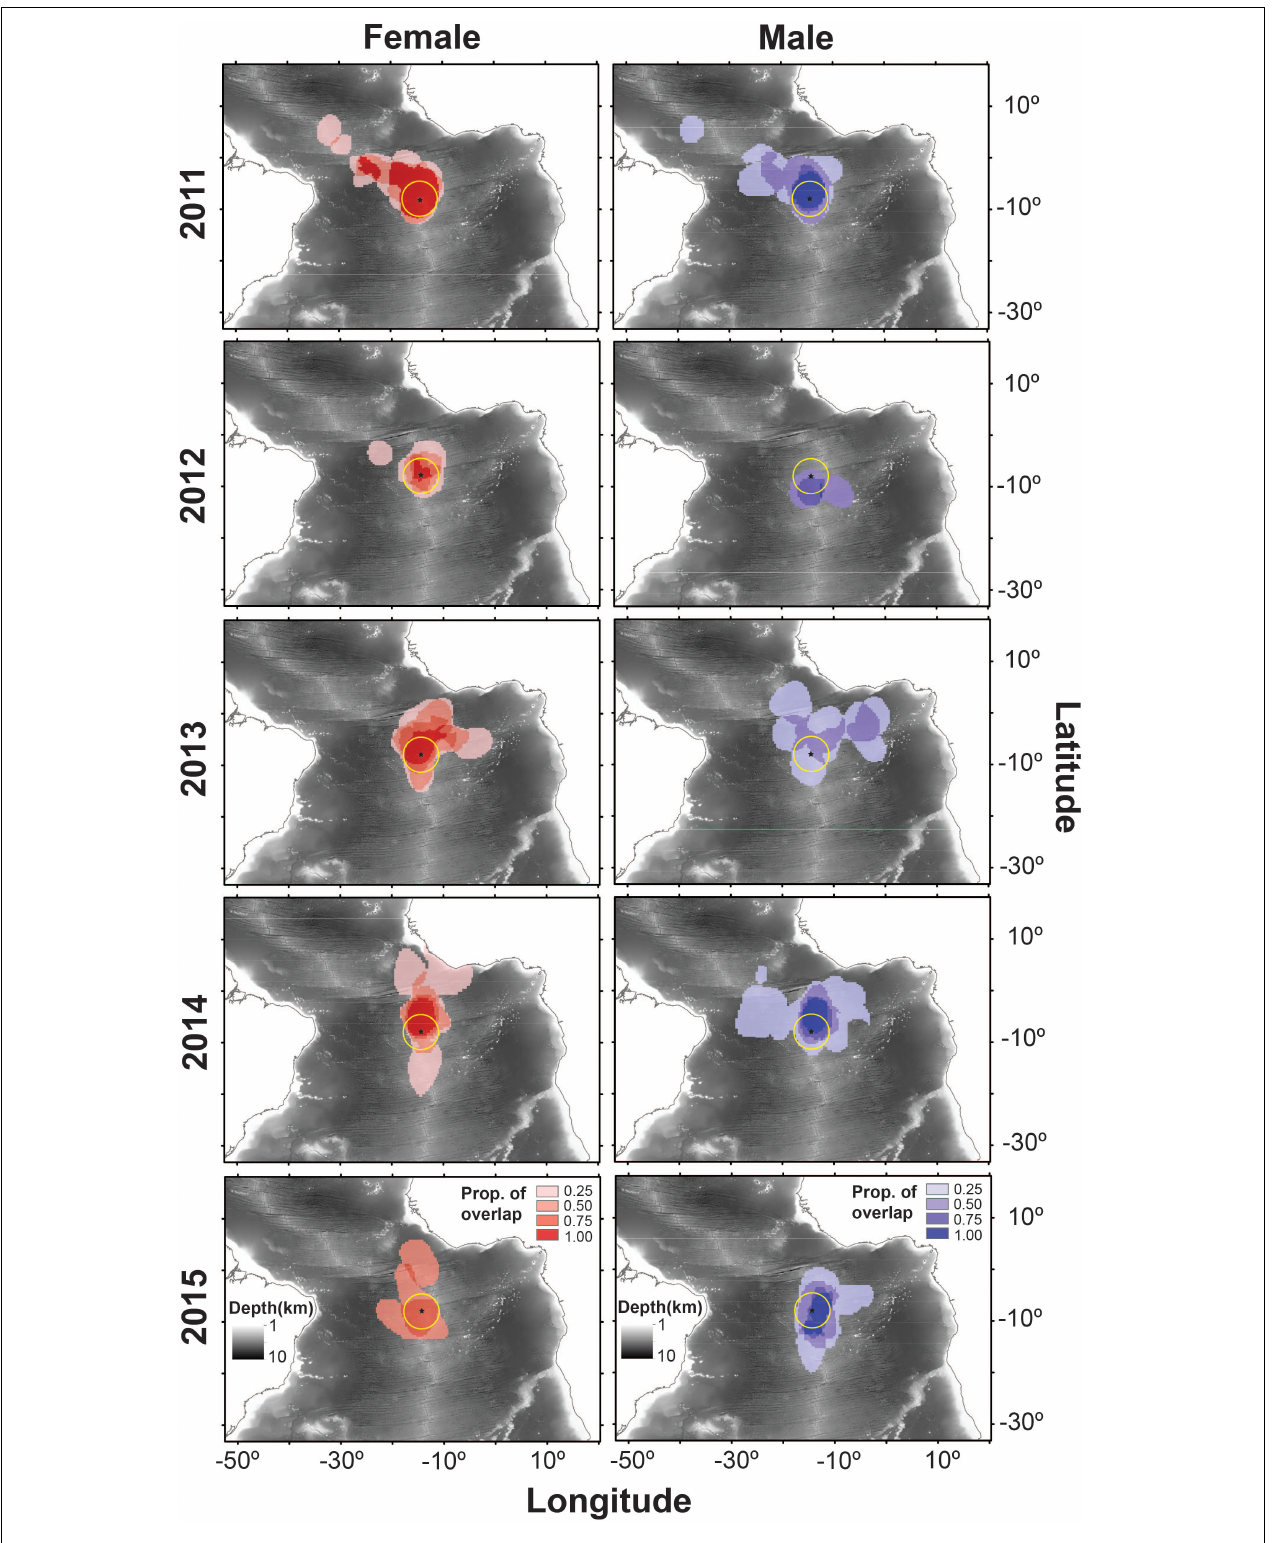
FIGURE 1 | Overlap of the individual 50% kernel utilization distributions (UDs) of female (red) and male (blue) sooty terns breeding on Ascension Island and then tracked during migration between 2011 and 2015. The yellow circle centered on the island is the MPA that extends 200 nautical miles around Ascension Island. Ocean depth is represented in the